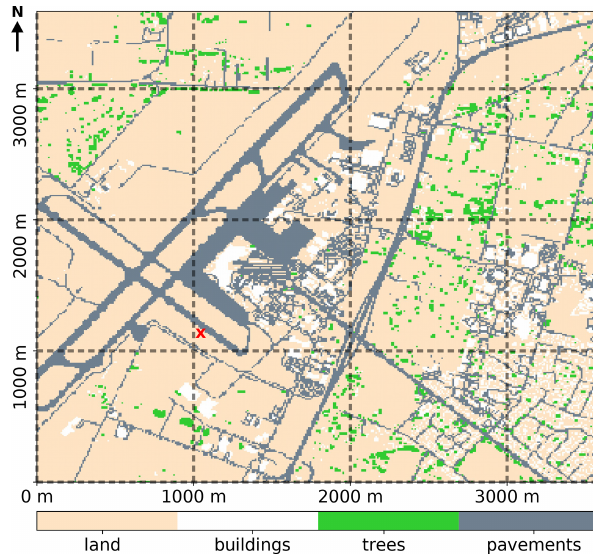
Figure 9. As in Fig. 3, but for the north-easterly case.